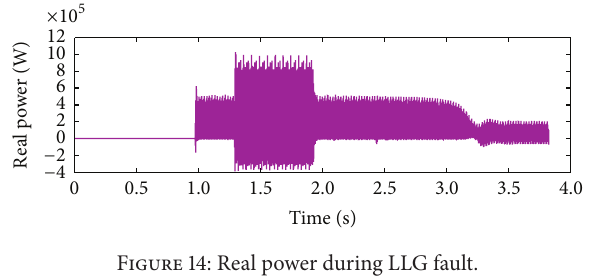
Figure 14: Real power during LLG fault.